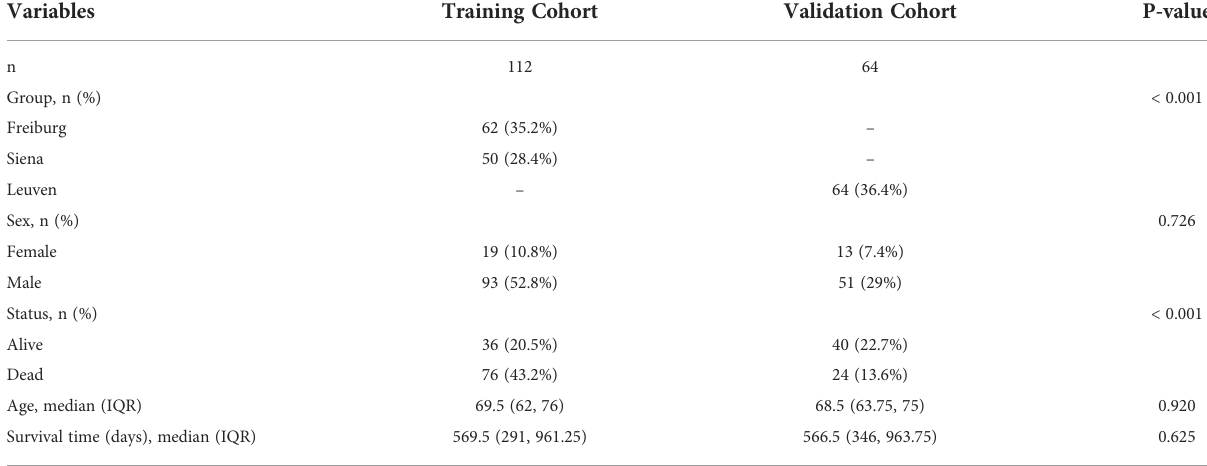
TABLE 1 Patients ’ features in the training and validation